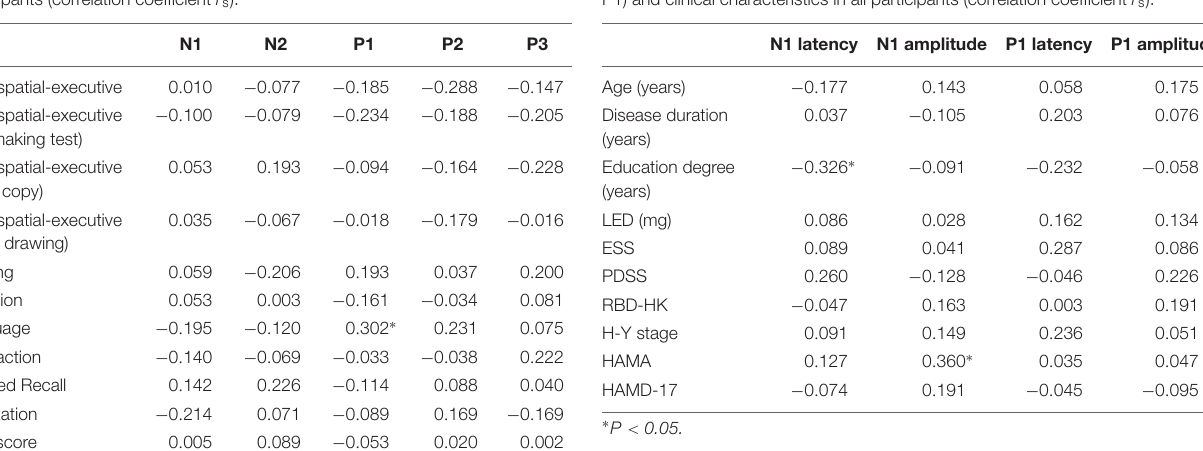
TABLE 7 | Correlation analysis between parameters of ERP components (N1 and P1) and clinical characteristics in all participants (correlation coefficient r s